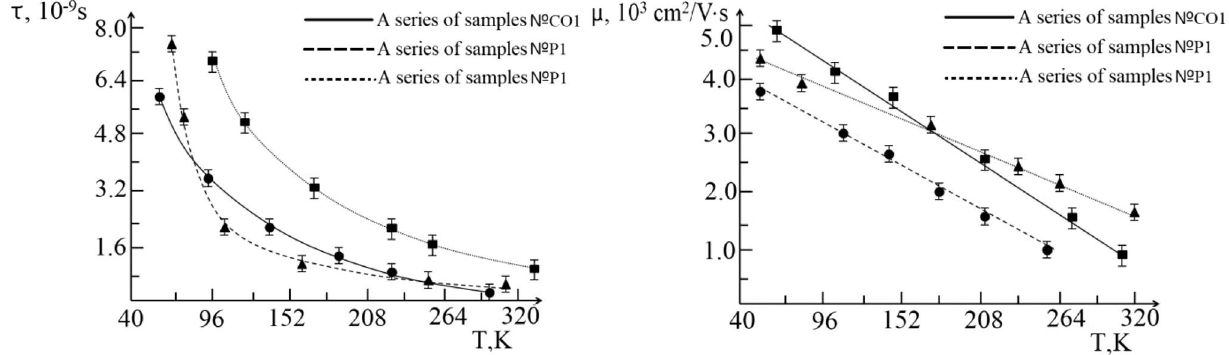
Fig. 6 Temperature relationships of relaxation time and electron mobility 2DEG for a series of InGaN/AlGaN/GaN heterostructure